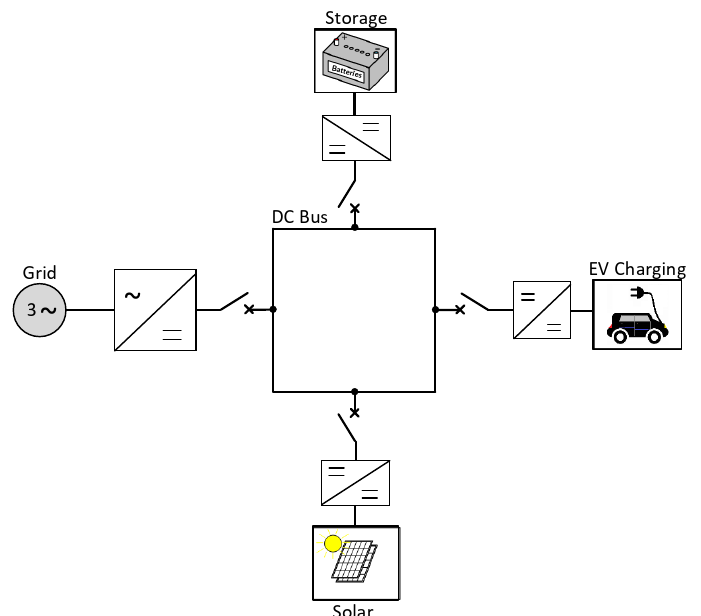
Figure 2. A schematic of typical example of the radial topology: ( a ) series configuration and ( b ) parallel configuration.